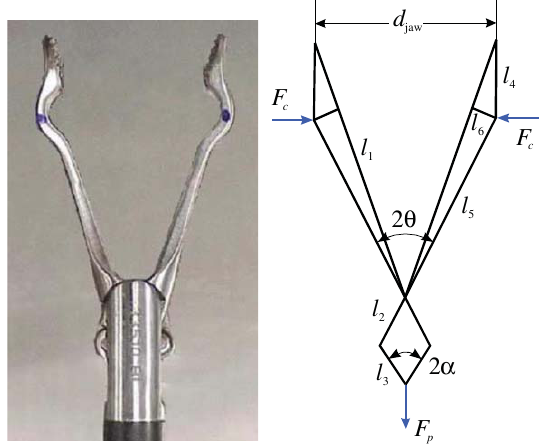
Fig. 7. (Left) A photograph of the grasper jaws without the sensor heads. The blue dots on the jaws indicate where the grasp force was measured by a digital force gauge. The tool measures force with a strain gauge at the other end of the tool shaft. (Right) A diagram of the mechanism with links and angles named. Equations 8 and 9 relate F c and F p .